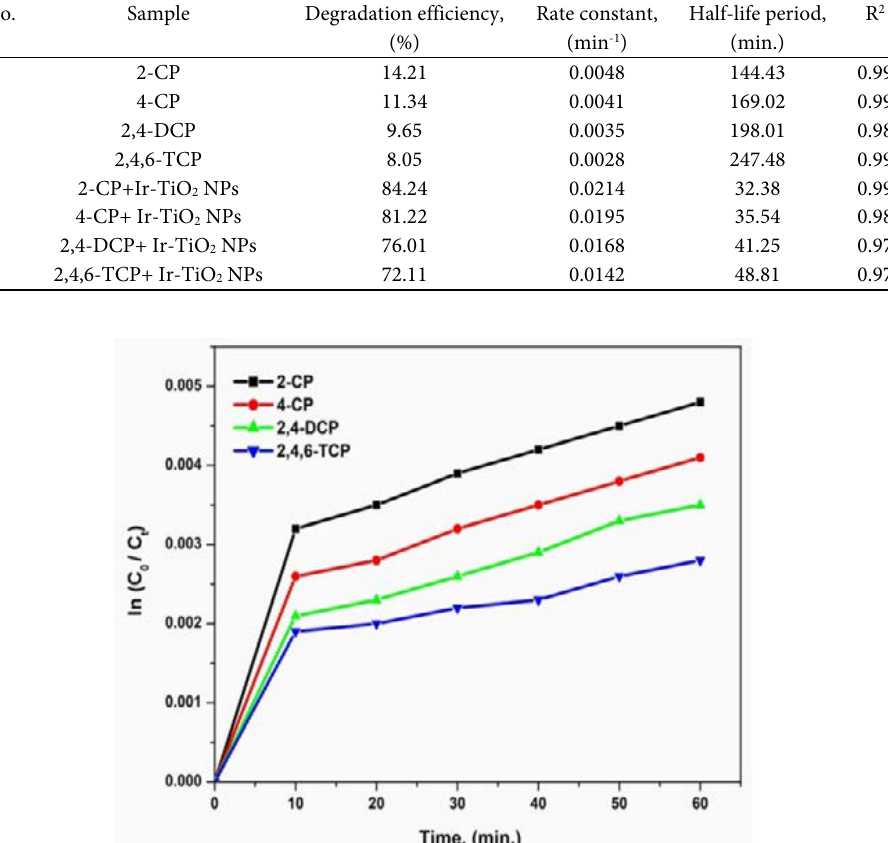
Table 1 The calculated photodegradation efficiency, rate constants and half-life period values of 2-CP, 4-CP, 2,4-DCP and 2,4,6-TCP in the absence and presence of Ir-doped TiO 2 NPs under sunlight irradiation S.No.